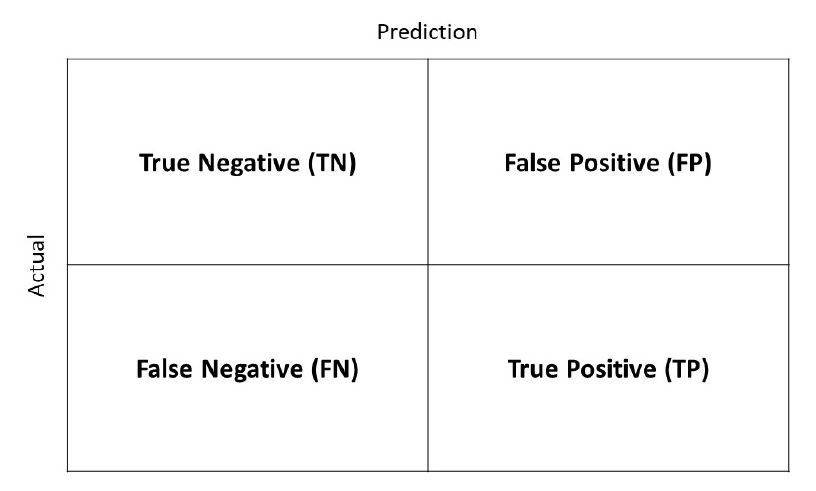
Figure 7. Formation of confusion